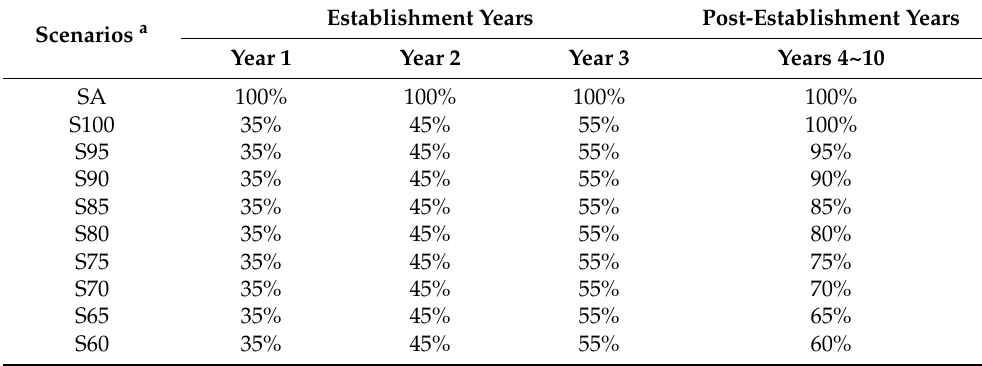
Table 3. Definition of scenarios based on probability meeting biorefinery annual demand.